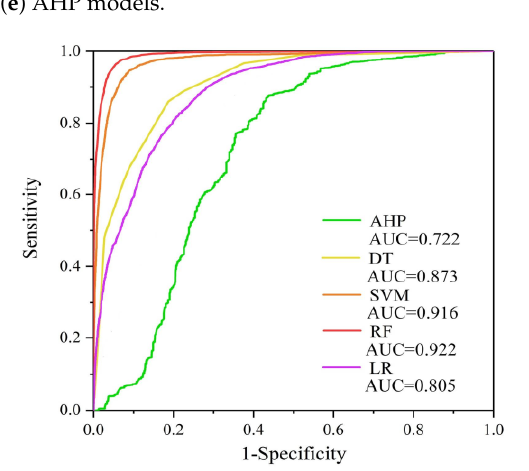
Figure 8. The landslide susceptibility maps produced by ( a ) LR, ( b ) DT, ( c ) RF, ( d ) SVM, and ( e ) AHP models.